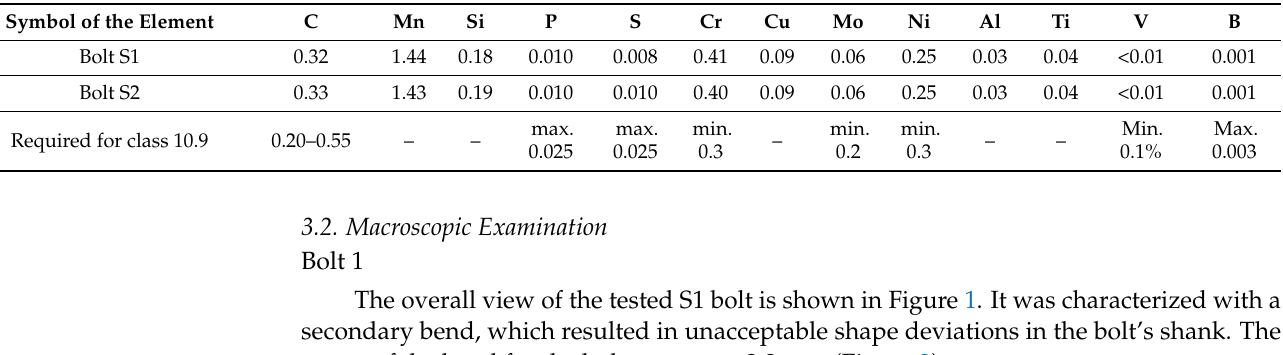
Table 1. Results of the spectral analysis of the chemical composition of the researched bolts.